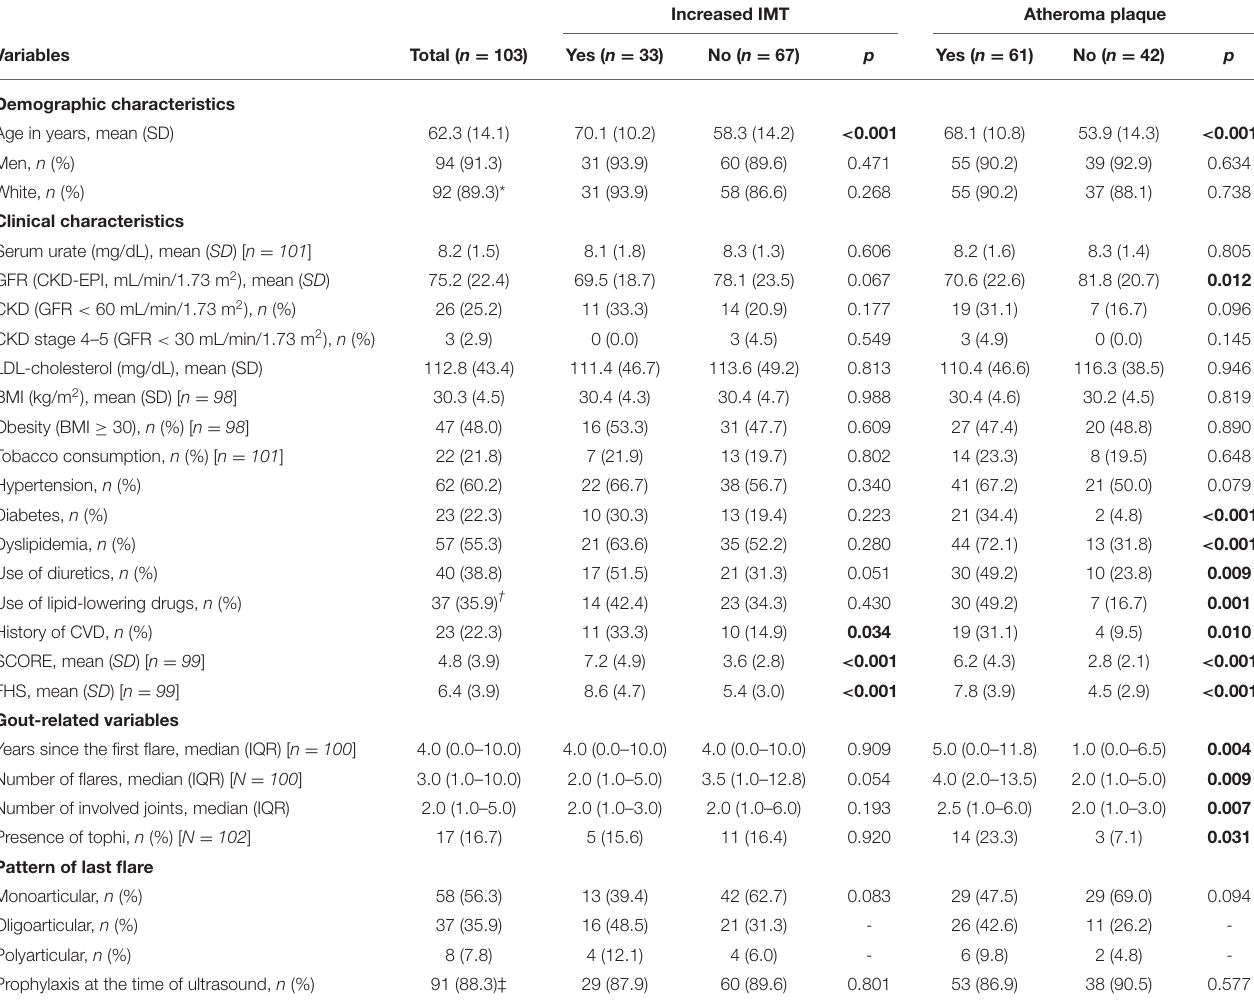
TABLE 1 | Participants’ characteristics and comparisons according to carotid ultrasound findings.